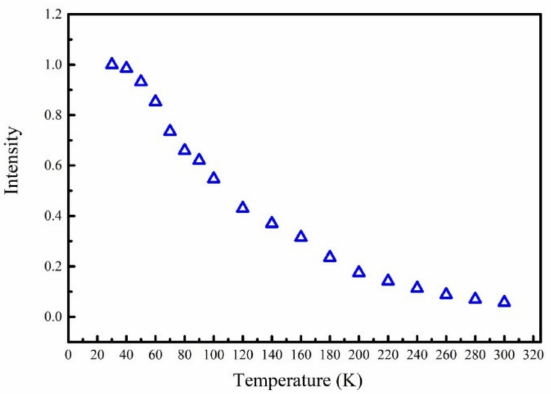
Figure 3. The normalized integrated PL intensity measured with 405 nm laser of sample A. Based on the above discussion, both the carriers generated in quantum barriers (B- carriers) and W-carriers contribute to the PL measured with a 325 nm laser. However, for the TDPL spectra measured with a 405 nm laser, only the W-carriers contribute to the radiative recombination process. Therefore, by comparing the normalized integrated PL intensity measured with 325 nm laser and 405 nm laser, one can effectively exclude the effect of W-carriers on the luminescence and gain a deeper insight of the effect of B-carrier on